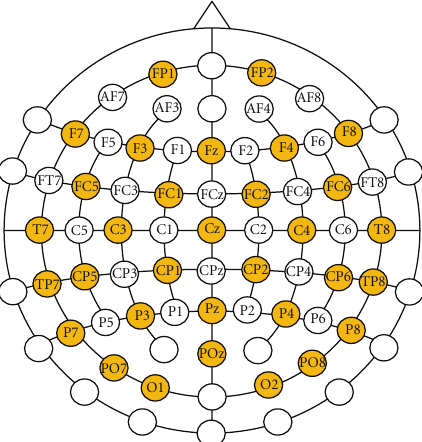
Figure 1: EEG channel montage. Only yellow channels were used for the online and o ffl ine analysis reported in this paper.